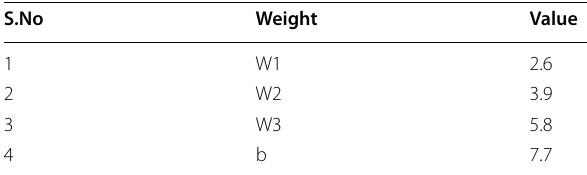
Table 8 Initial value of